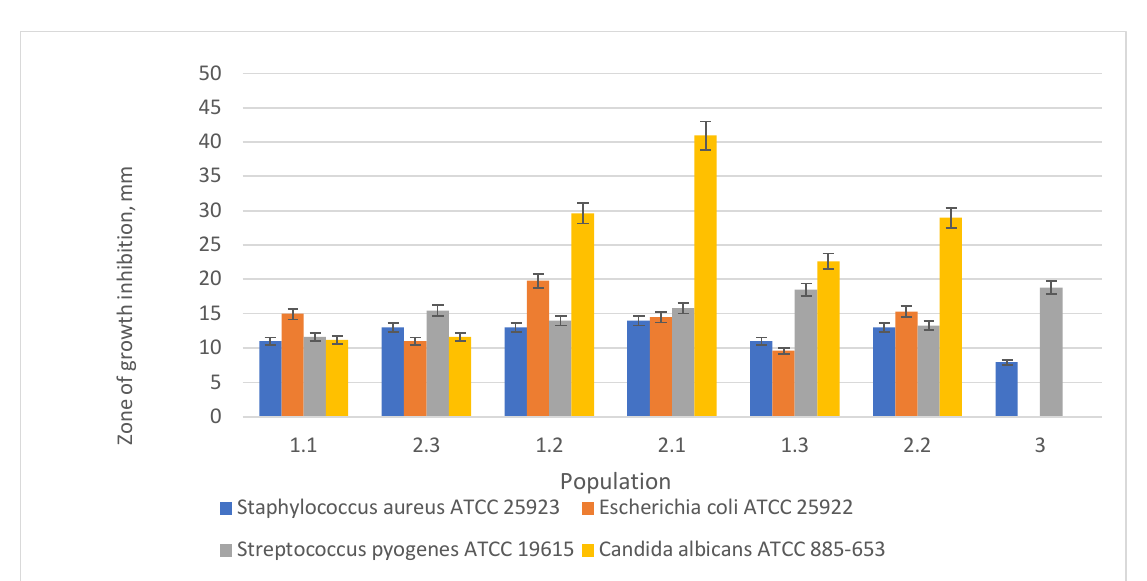
Figure 3. Antimicrobial and fungicidal action of raw materials of species of the genus Thymus from different habitats, M ± m. Legend: notations are similar as in Figure